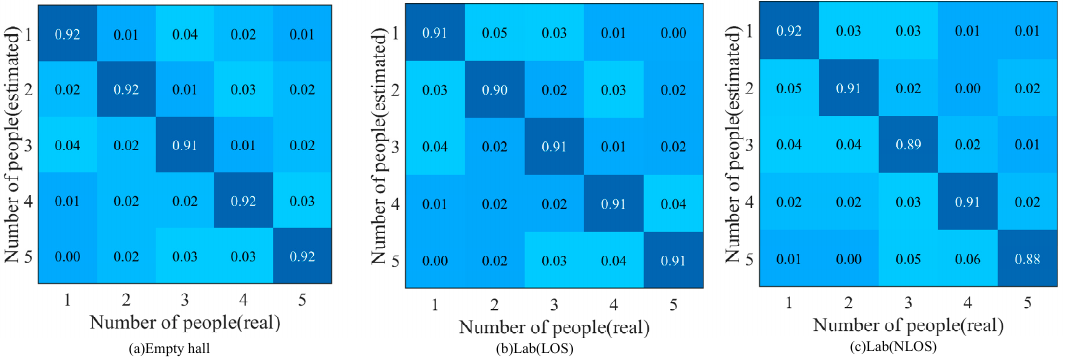
Figure 6. Method performance in three environments. ( a ) Empty hall, ( b ) Lab (LOS), ( c ) Lab (NLOS).